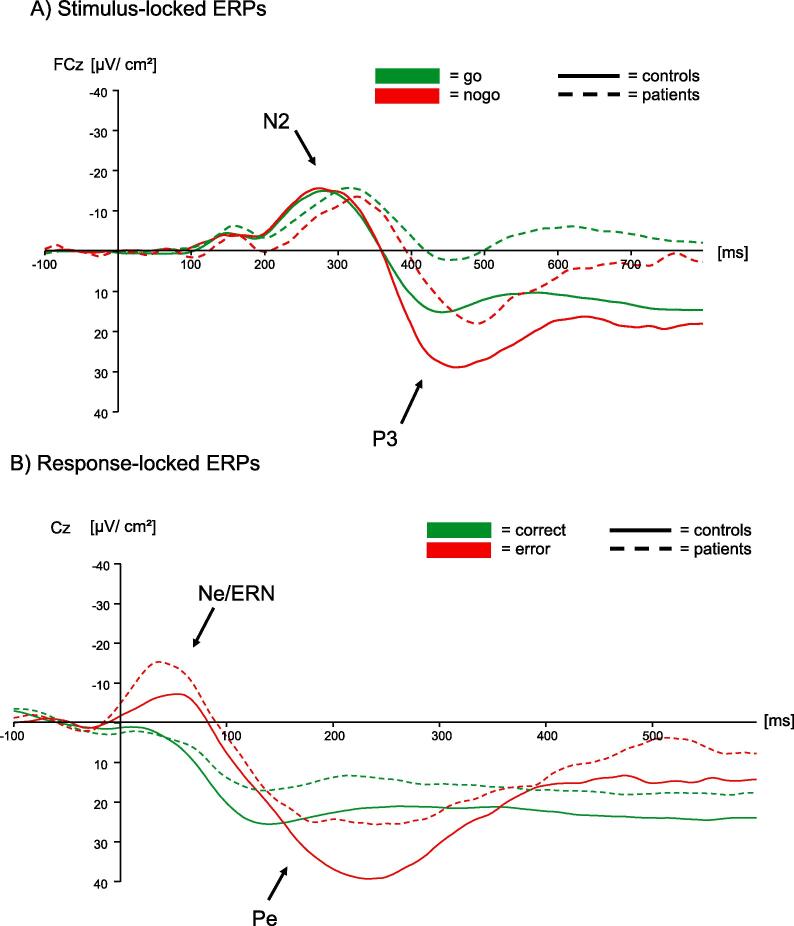
Main results of stimulus- and response-locked ERPs A) The N2 and P3 components are shown for correct responses to go stimuli (green) and correct withholds after nogo-stimuli (red) for all participants. Dashed lines represent the patient group, and the bold line represents healthy controls. Independent of response type, the N2 peaked later in patients than in controls. The P3, being larger in amplitude for nogo than go trials, was smaller in amplitude for patients than for controls. B) For all participants who made at least six detected errors (17 patients and 24 controls), the Ne/ERN and Pe components are illustrated for correct responses after go-stimuli (green) and detected errors (red). The Ne/ERN was larger for errors than for correct responses, but there was no significant difference between the groups. The same was true for the Pe component for which again no significant group difference emerged. For illustrative purposes only, results are plotted using a high cut-off filter (10 Hz, 12 dB/oct). (For interpretation of the references to color in this figure legend, the reader is referred to the web version of this article.)